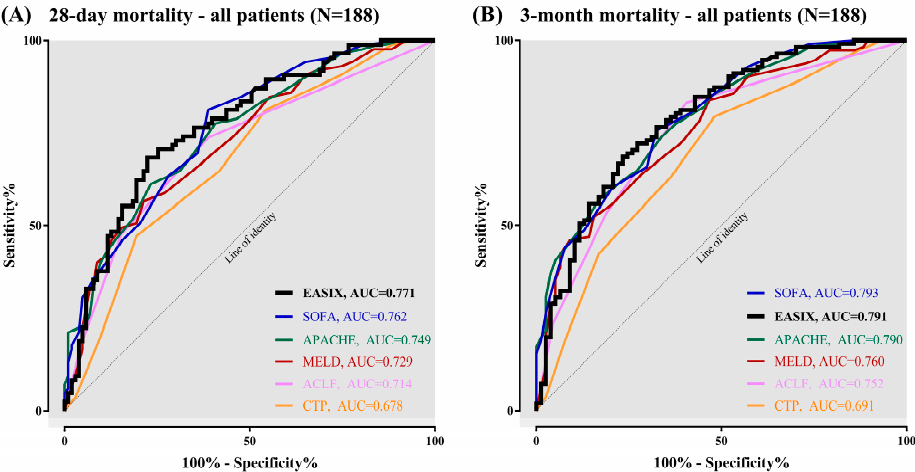
Figure 1. Prognostic accuracy of EASIX versus clinical scores to predict mortality in patients with advanced liver disease (N = 188): ( A ) 28-day mortality; and ( B ) 3-month mortality.